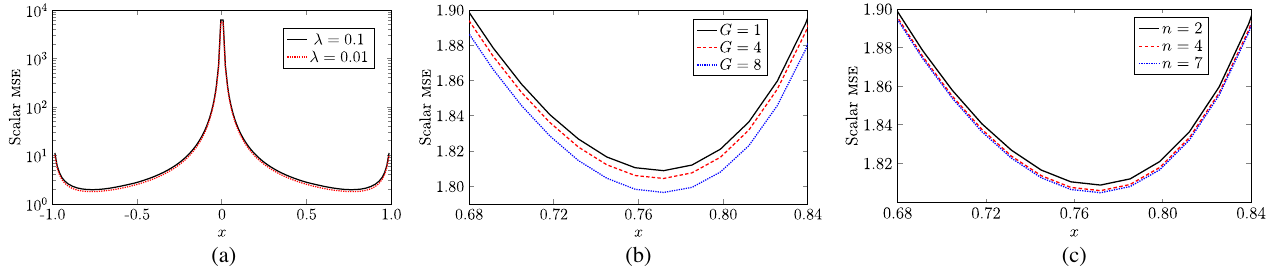
FIG. 8. Variation of HCRB with thermalization and binomial code parameters. For the plot in (a), we take n ¼ 2 , β ¼ 0 . 01 , and G ¼ 1 . In (b), we see the effect of noise by varying the number of correctable amplitude damping errors of the binomial code, using n ¼ 2 , λ 0 . 01 , and β ¼ 1 . In (c), we illustrate the effect of increasing the correctable phase errors of the binomial code on the HCRB using th ¼ λ 0 . 01 , β ¼ 1 , and G ¼ 1 . (a) Thermalisation effect. (b) Amplitude damping error parameter, G . (c) Phase error parameter, n th ¼ Algorithm 4 to evaluate upper and lower bounds to the HCRB for fixed u to benchmark parameter estimates for θ .